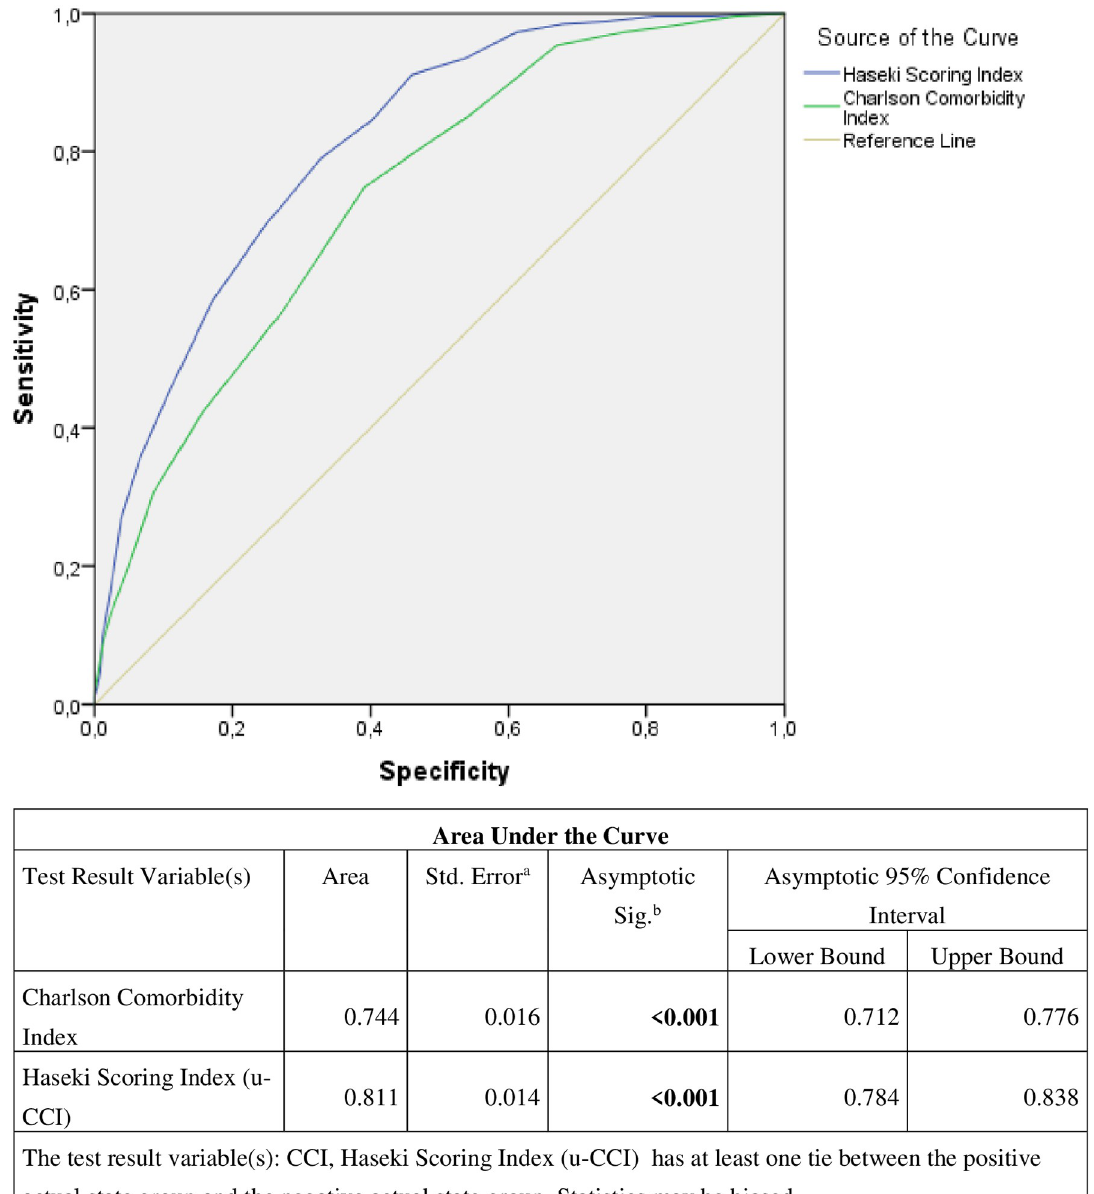
Fig 2. Roc analysis of Haseki Scoring Index (u-CCI) and Charlson Comorbidity Index in 3-month